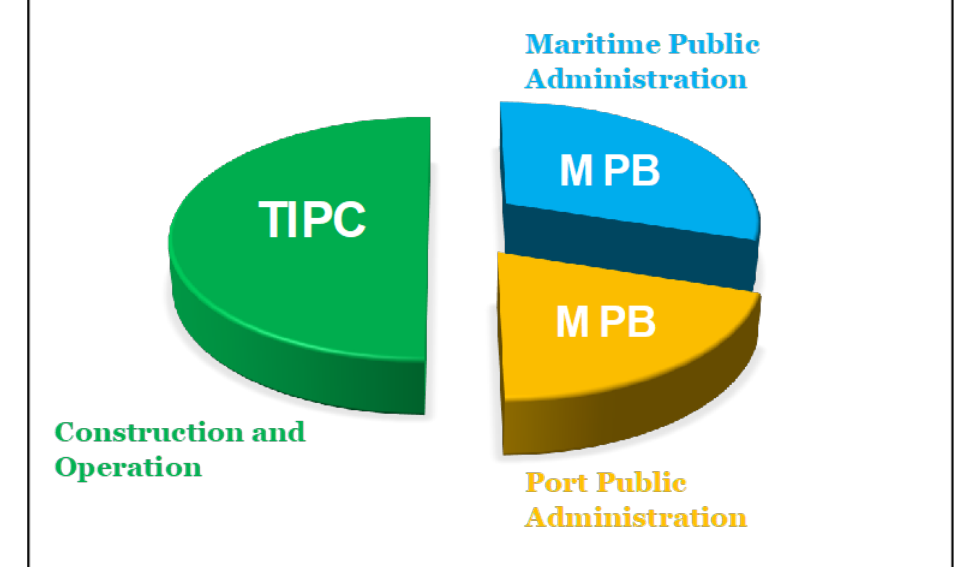
Figure 4. Division of authority and responsibility of commercial ports.